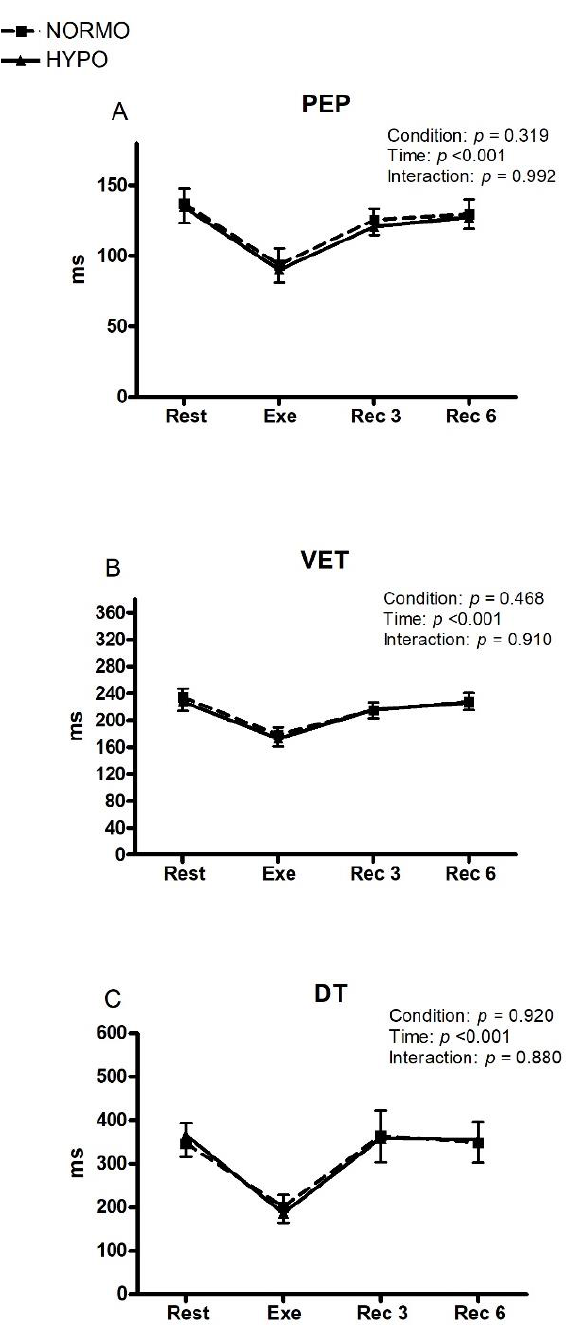
Figure 4. Changes in the level of pre-ejection period (PEP, panel A ), ventricular ejection time (VET, panel B ), and diastolic time (DT, panel C ) during the sessions of exercise in normoxia (NORMO) and in normobaric hypoxia with a FiO 2 of 13.5% (HYPO). Values are mean with 95% confidence interval. N = 22.